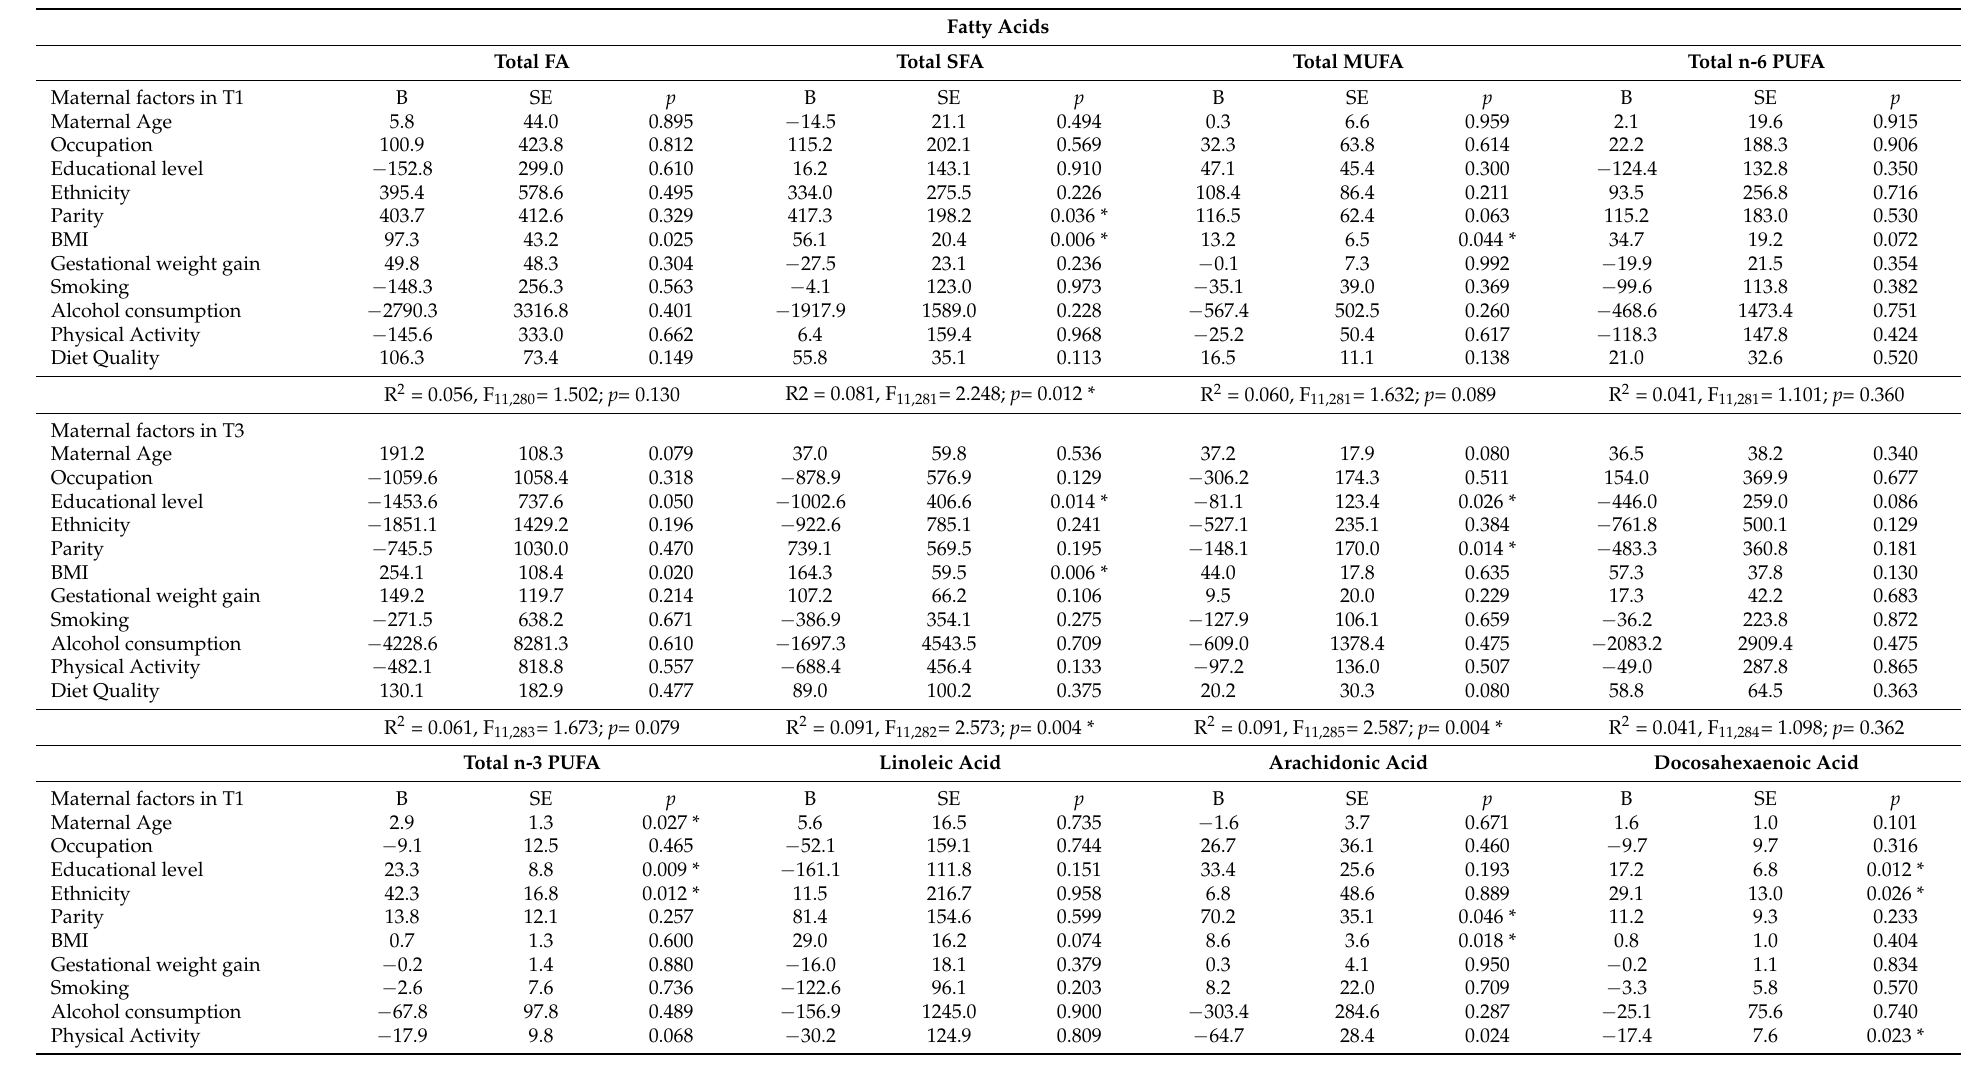
Table 5. Multiple linear regression of potential factors related to maternal serum fatty acids composition in the first (T1) and third (T3) trimesters of pregnancy. Fatty Acids Total FA Total SFA Total MUFA Total n-6 PUFA Maternal factors in